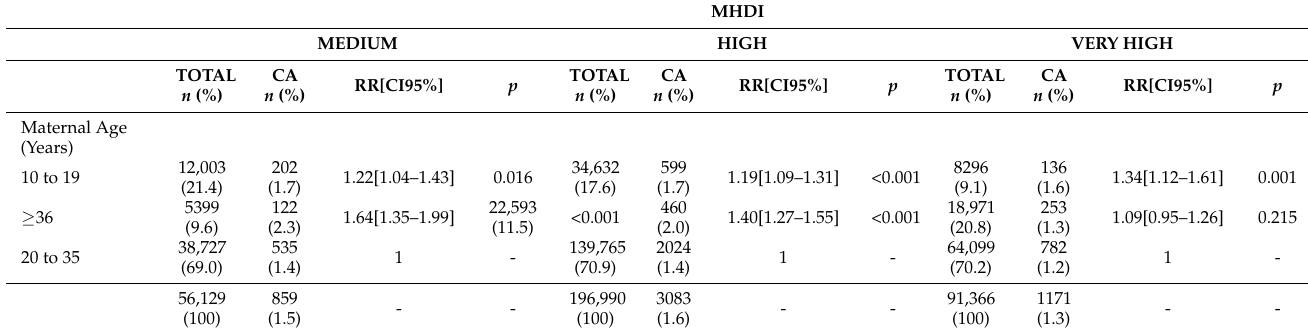
Table 1. Distribution of absolute frequency and association of sociodemographic, perinatal, and neonatal characteristics on congenital anomaly according to the MHDI classification in Porto Alegre from 2000 to